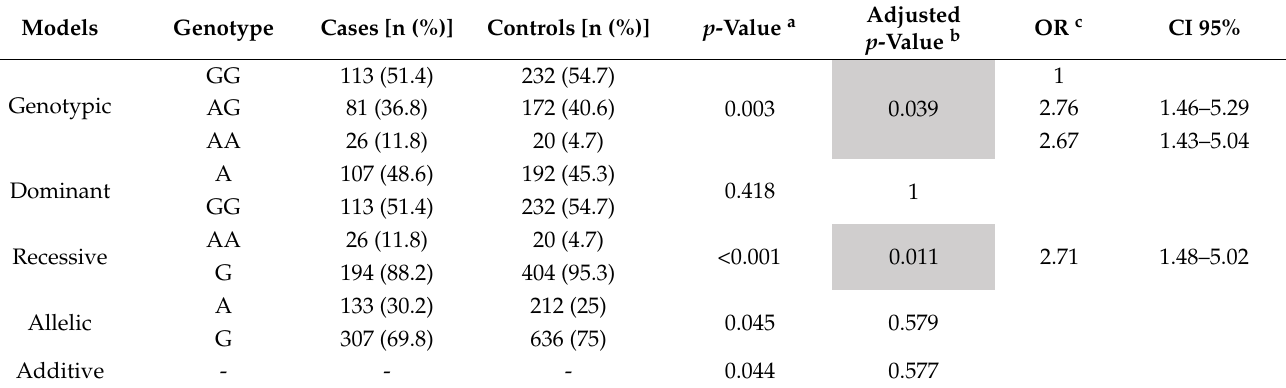
Table 3. Effect of the Cdx2 (rs11568820) polymorphism on susceptibility to asthma.